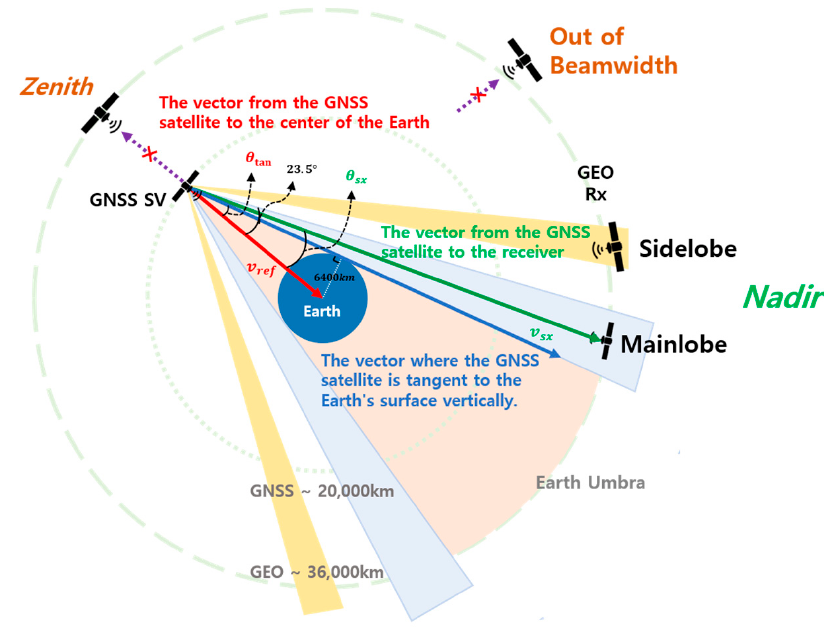
Figure 2. Sequential search acquisition schema.